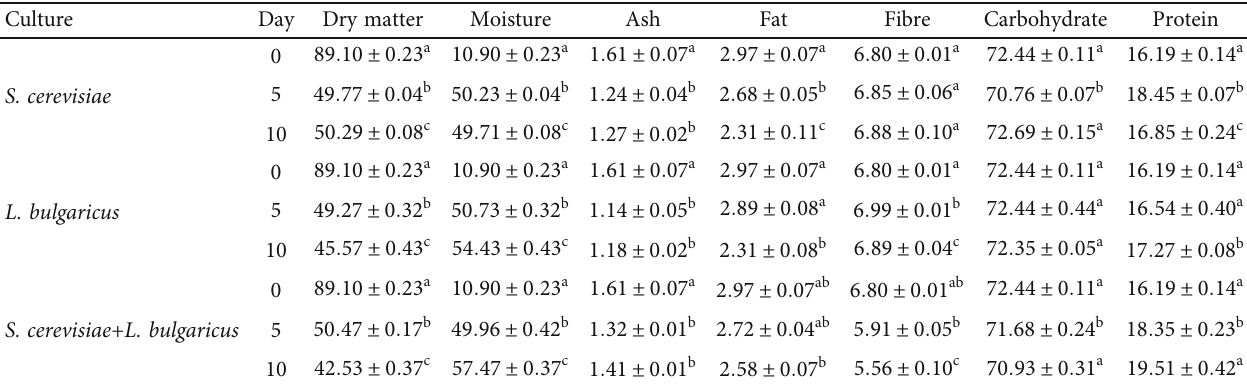
Table 4: Changes in the chemical composition of fermented, formulated blends of unmalted and malted sorghum in a ratio of 1 :1 ( w / w ) with monocultures of S . cerevisiae or L . bulgaricus and a coculture of S . cerevisiae and L . bulgaricus (data presented are based on the dry matter). a – c Means within a column with di ff erent superscripts are signi fi cantly di ff erent ( p ≤ 0 : 05 ). Results expressed as mean ð n = 3 Þ ± SD (standard deviation).